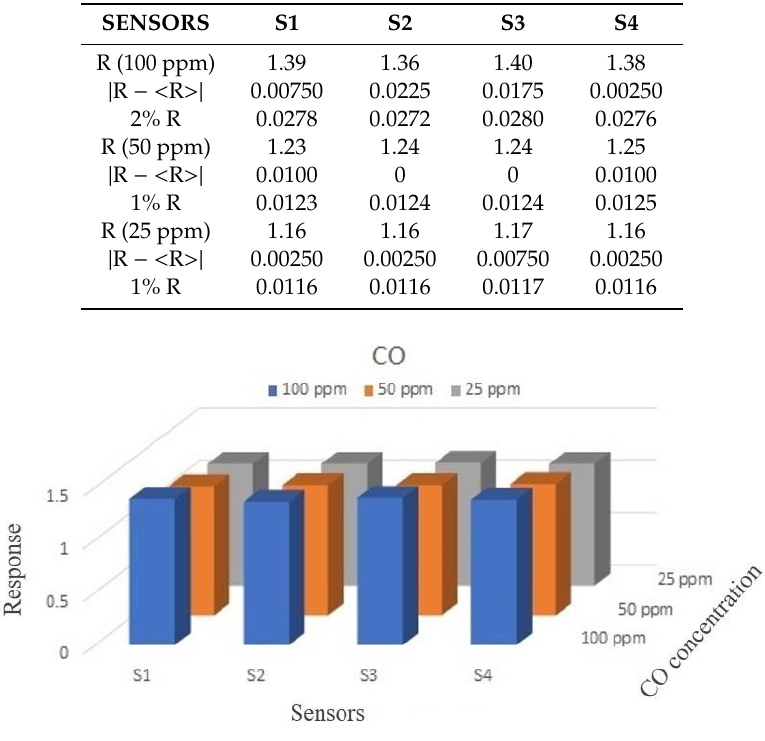
Figure 6. Histogram of the responses of the four SmFeO 3 sensors, S1, S2, S3 and S4 (T = 350 °C) to 25, 50 and 100 ppm of CO.